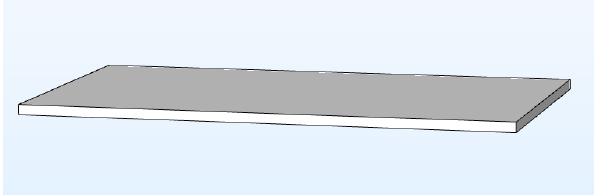
Figure 10. PVDF film drawn using the software.